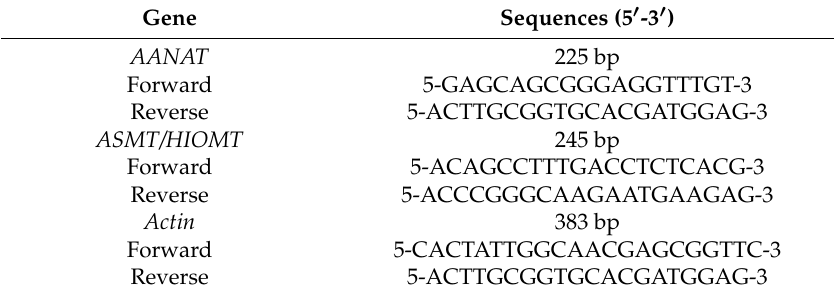
Table 3. Primers for